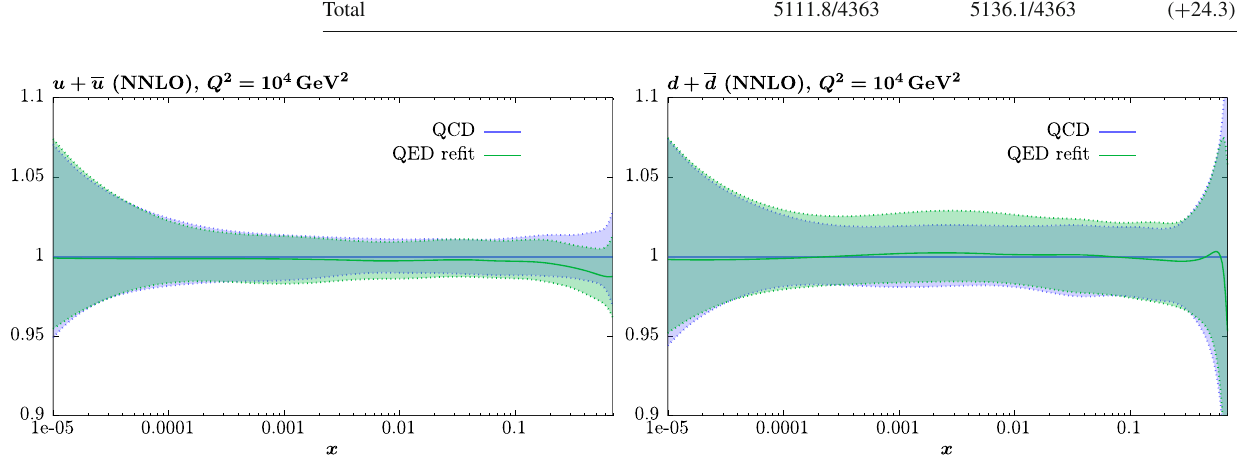
Fig. 2 The ratio of the u + u and d + d distributions (with uncertainties) at Q 2 = 10 4 GeV 2 , resulting from NNLO fits to the MSHT20 dataset, with QED effects included to that